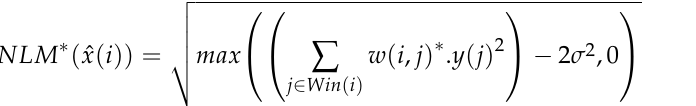
Table 1. Acquisition parameters for analyzed datasets of articular cartilage and elbow muscle.